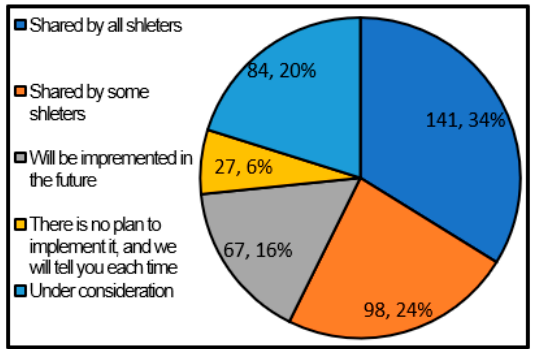
Figure 10. Sharing of awareness about the shelter operating entity (single answer) (Single answer, total number of answers 417, total number of local governments: 417, unit: group).